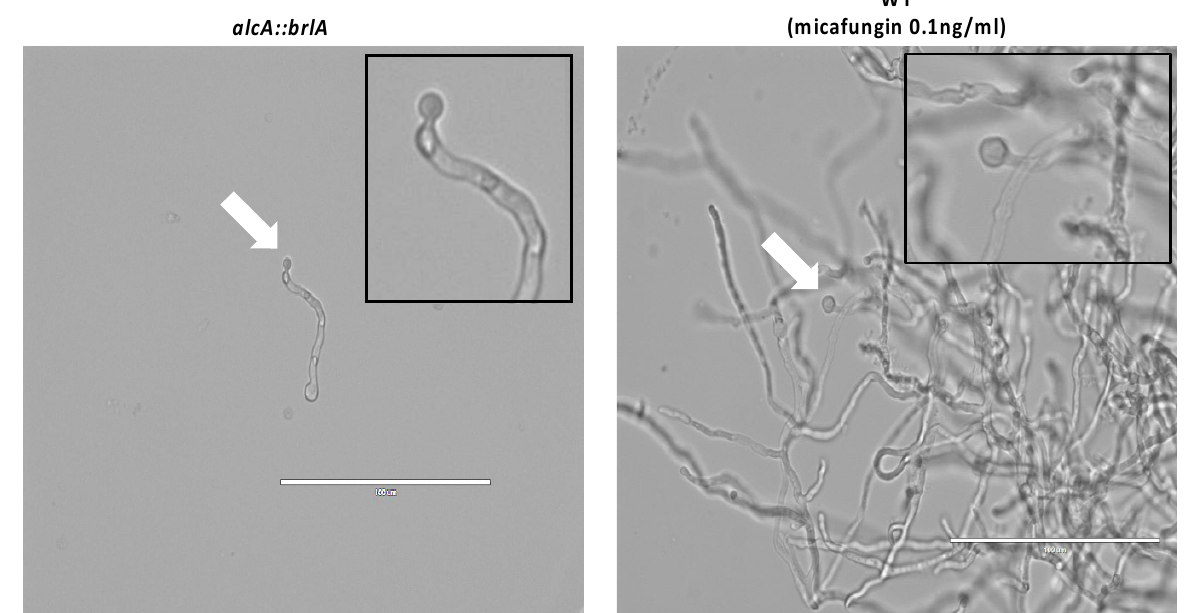
Figure 6. Similar Microcycle Spore Generation Similar spore phenotypes in up-regulated brlA strain after three hours promoter induction and wildtype nine hours post micafungin exposure (white arrows). 40× magnification. Scale bar is 100 µm. Pictures taken on EVOS FL microscope.